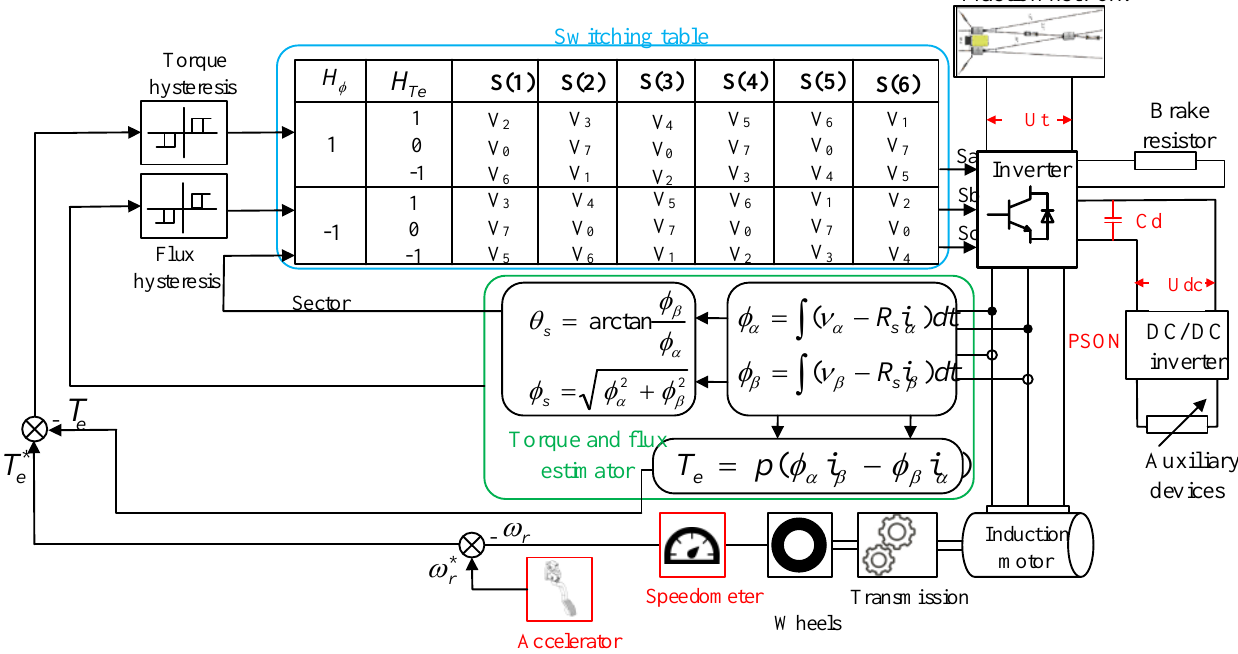
Torque and flux estimator